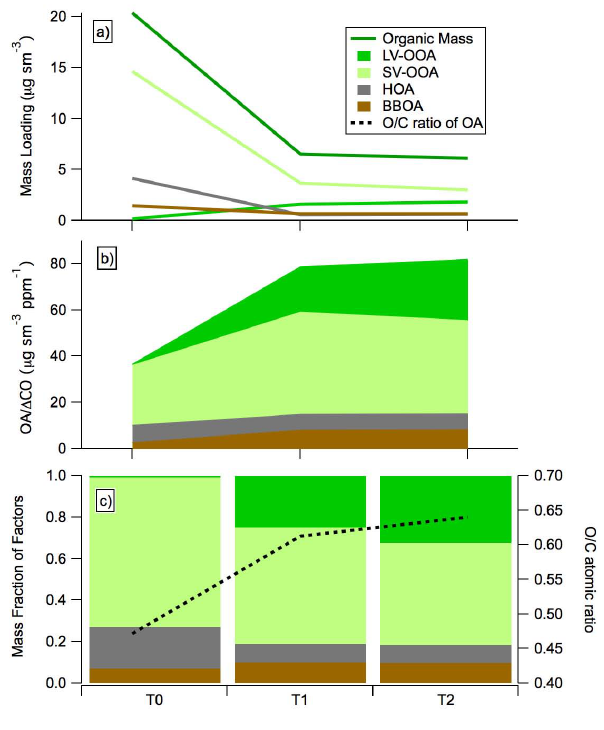
Fig. 7. (a) shows the average absolute concentration of OA and PMF factors for each flight segment in the vicinity of T0, T1, and T2, respectively during RF12. (b) shows the average PMF Factor/ 1 CO ratio for each flight segment. (c) shows the mass frac- tion of each PMF factor and the mass-weighted average OA O/C atomic ratio for each flight